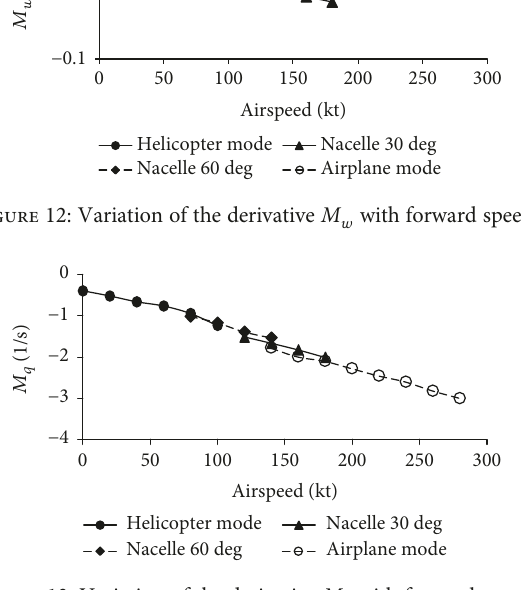
with forward speed. u